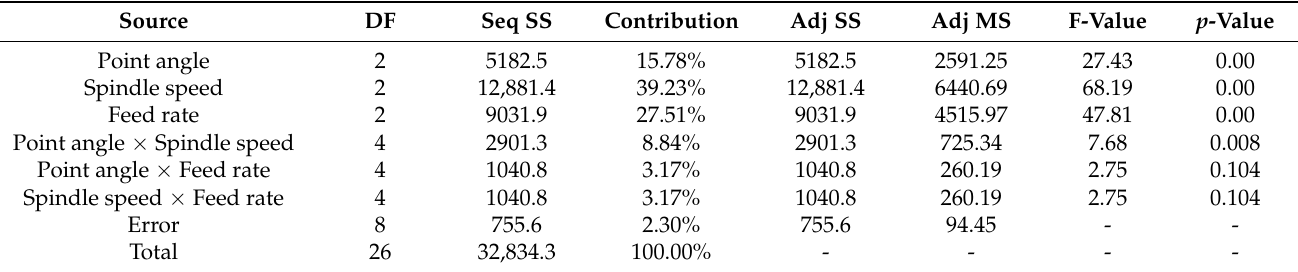
Figure 4. Variation in thrust force on redmud-filled sisal composite structures at different point angles: ( a ) 90 ◦ , ( b ) 118 ◦ , and ( c ) 135 ◦ . Table 4. ANOVA results of thrust force